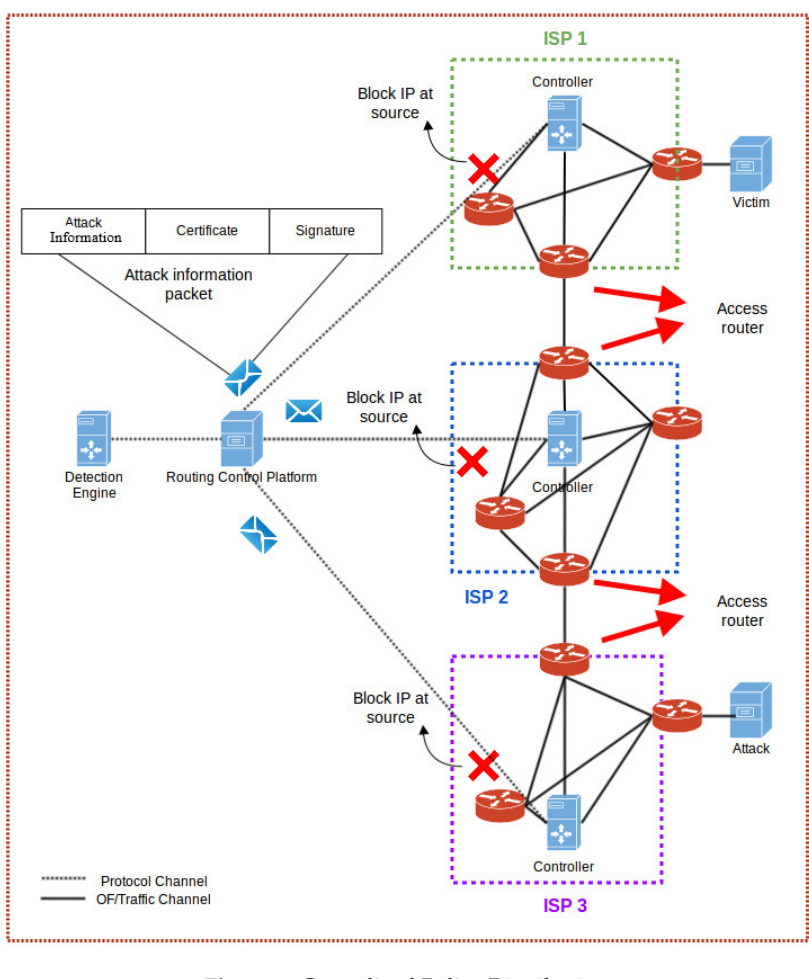
Figure 5. Centralized Policy Distribution.